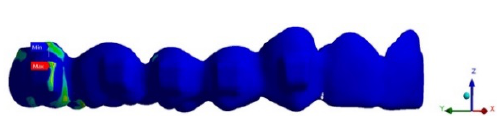
Figure 7. ATT 3–7 contact pressure.